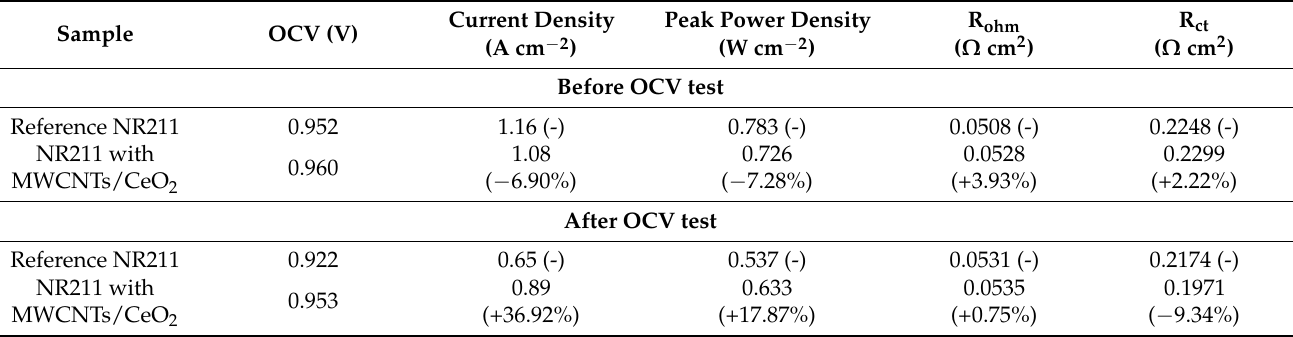
Figure 4. ( a ) OCV decay spectra over 72 h under accelerated conditions. Polarization curves ( b ) before and ( c ) after the OCV holding test. Corresponding EIS spectra at 0.6 V ( d ) before and ( e ) after the OCV holding test. Table 3. Summary of the key parameter